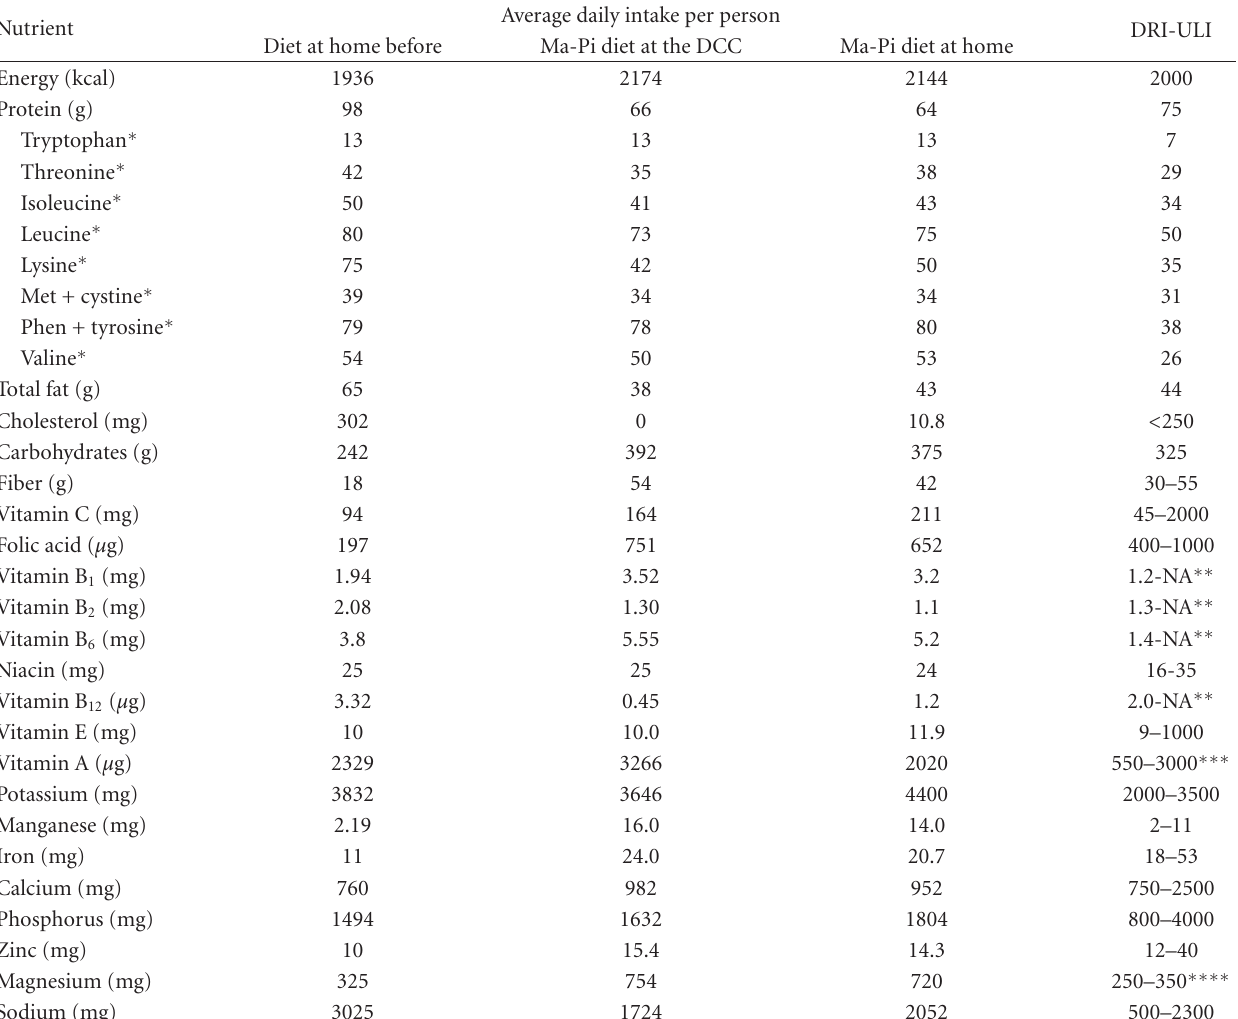
Table 1: Average daily energy and nutrients intake during the assay periods versus Dietary Reference Intake (DRI) values and tolerable upper intake limits